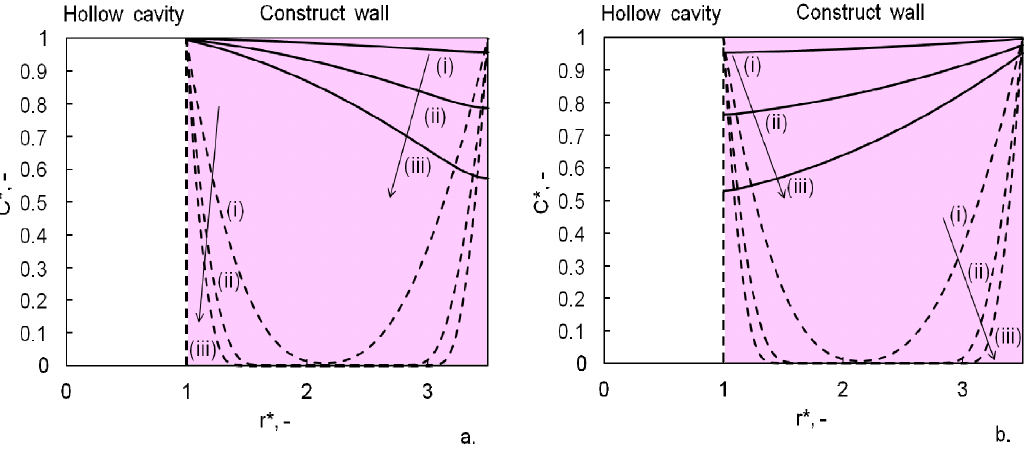
Figure 3. Dimensionless radial oxygen radial concentration profiles at varying maximal oxygen consumption rates V : (i) 1.76 × 10 − 10 mol/(s mL); (ii) 8.8 × 10 − 10 mol/(s mL); max (iii) 1.76 × 10 − 9 mol/(s mL) for cells cultured in a hollow cylindrical construct in an rPBB radially perfused with medium (solid lines) ( a ) outward or ( b ) inwards, or (dashed lines) statically operated. Parameter values: R / δ = 0.4, Pe = 49. Other parameters are as in i C rad ,max Tables 2 and